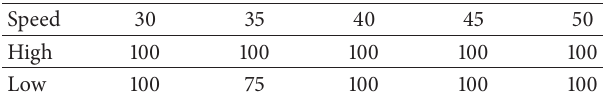
Table 3: The performance of 𝑘 -NN in FSFL model when the 1D LBP scheme is used for feature extraction.